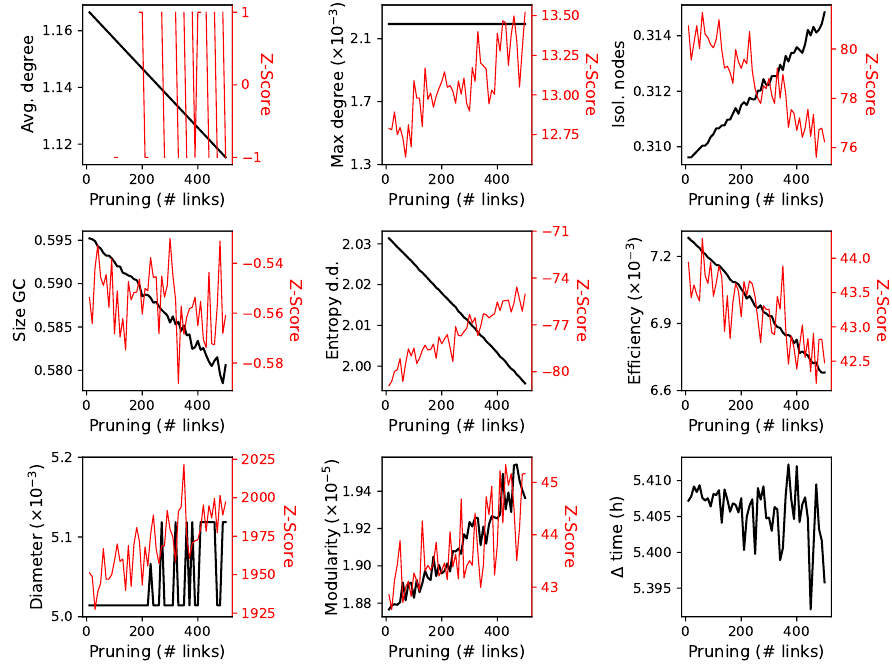
Figure A12. Properties of the interaction network for executed trajectories of 1 September, subject to a random pruning process. Metrics are reported as a function of the number of deleted links, with links being deleted at random. Black (left Y axes) and red lines (right Y axes), respectively, correspond to the raw values and their